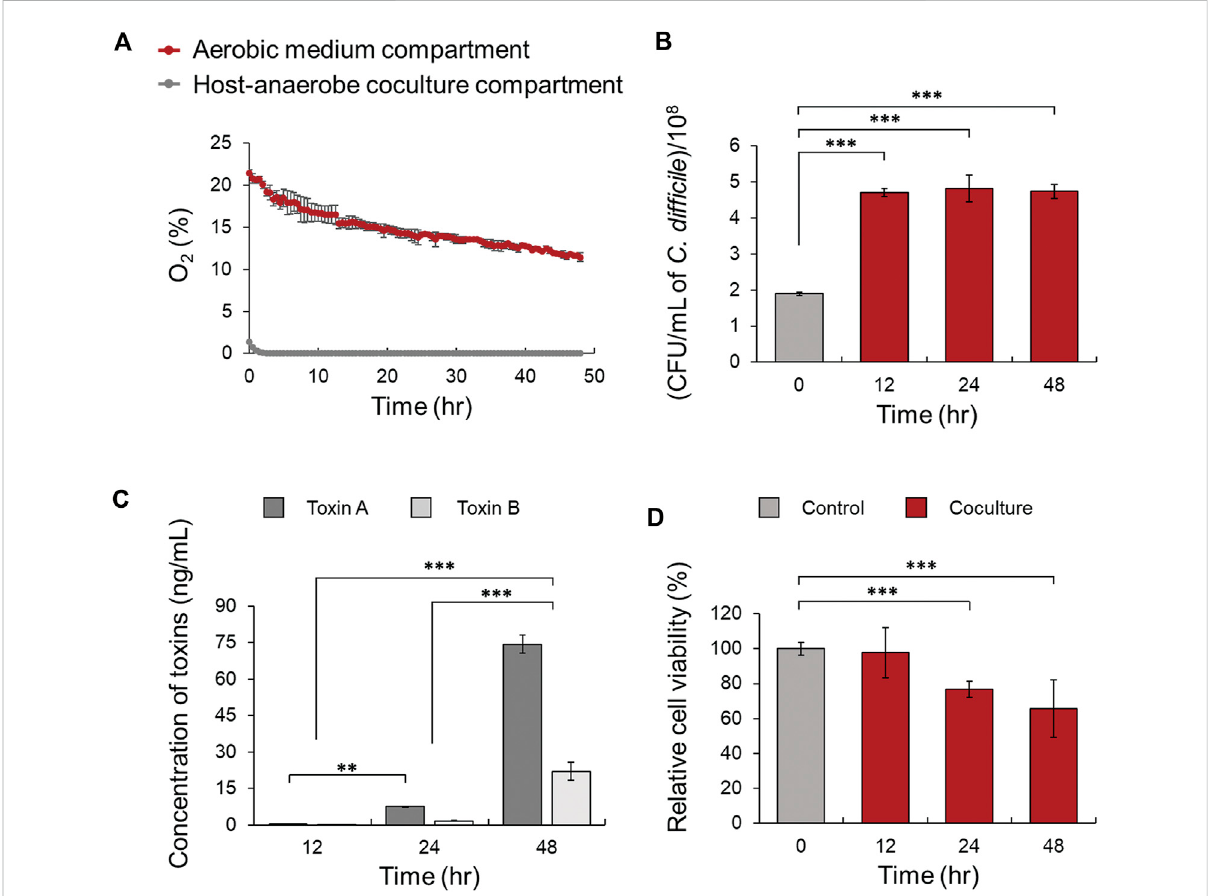
FIGURE 2 (A) Comparisonofoxygenconcentrationinthehost-anaerobecocultureandaerobicmediumcompartmentsintheMIMICS. (B) Comparisonof the viability of C. dif fi cile cultured with Caco-2 cells in MIMICS for 0, 12, 24, and 48 h. (C) Production of toxins A and B at 12, 24, and 48 h. (D) Comparison of the viability of Caco-2 cells according to coculture with C. dif fi cile at 0, 12, 24, and 48 h compared to the control. Control means monoculture of Caco-2 cells. The error bars represent the standard deviation of triplicate samples. * p < 0.05, ** p < 0.01, *** p <